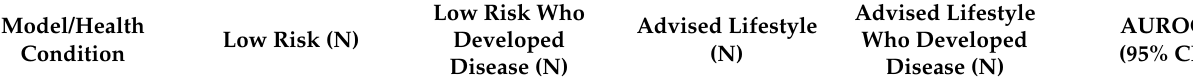
Table 3. Area under the receiver operating characteristic (AUROC) curve for model discrimination of higher risk individuals amenable to lifestyle intervention assessed for the clinical risk score(s), PRS, and decision rules model. Number of individuals classified as low and higher risk and number of individuals who had developed disease at follow-up are also